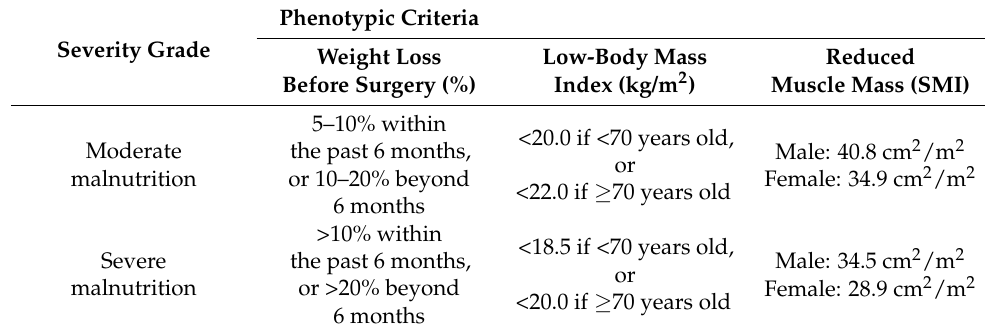
Table 1. Severity grade as defined by the GLIM criteria in the present study.